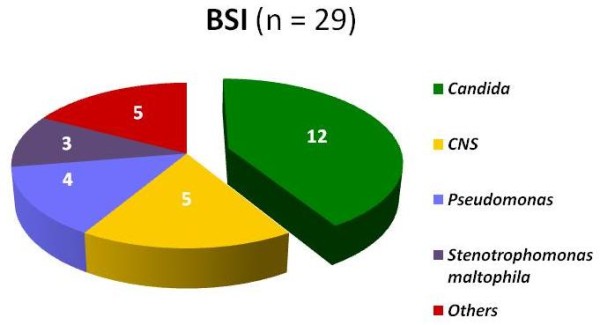
Pathogens isolated in ICU patients with BSI. Candida spp was the most common microorganism in bloodstream infection.